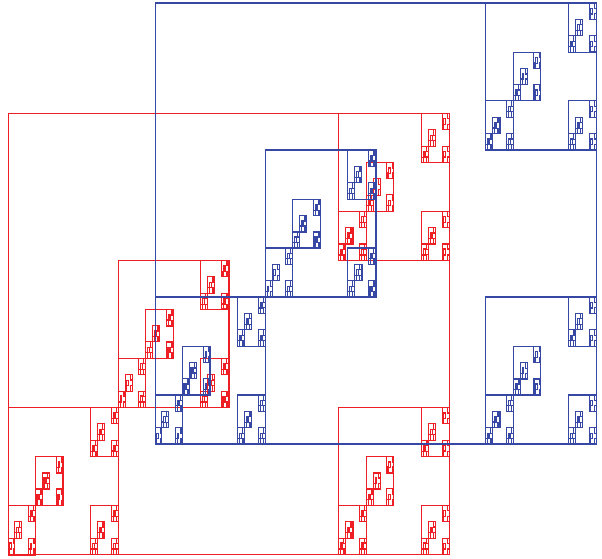
Figure 1: Construction of 𝐾∩𝐾+𝑡 . Red and blue rectangles denote the construction of 𝐾 and 𝐾 + 𝑡 ,